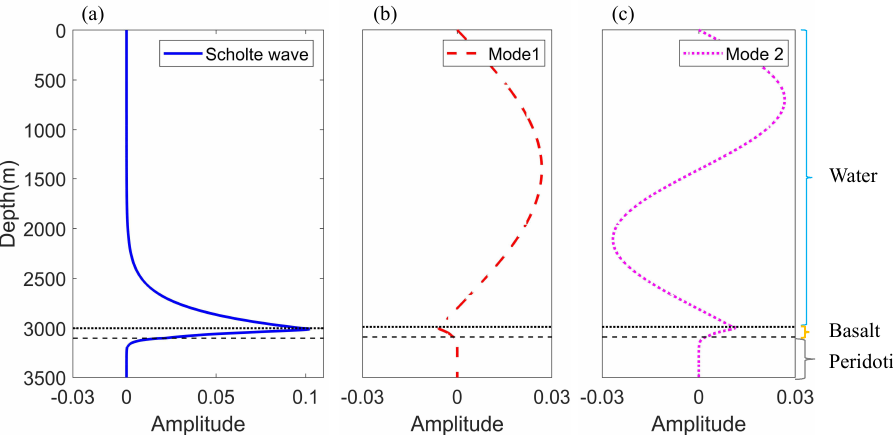
Figure 2. Pressure mode shape functions for a 10 Hz source in the ocean acoustic model. ( a ) Scholte wave. ( b ) Mode 1. ( c ) Mode